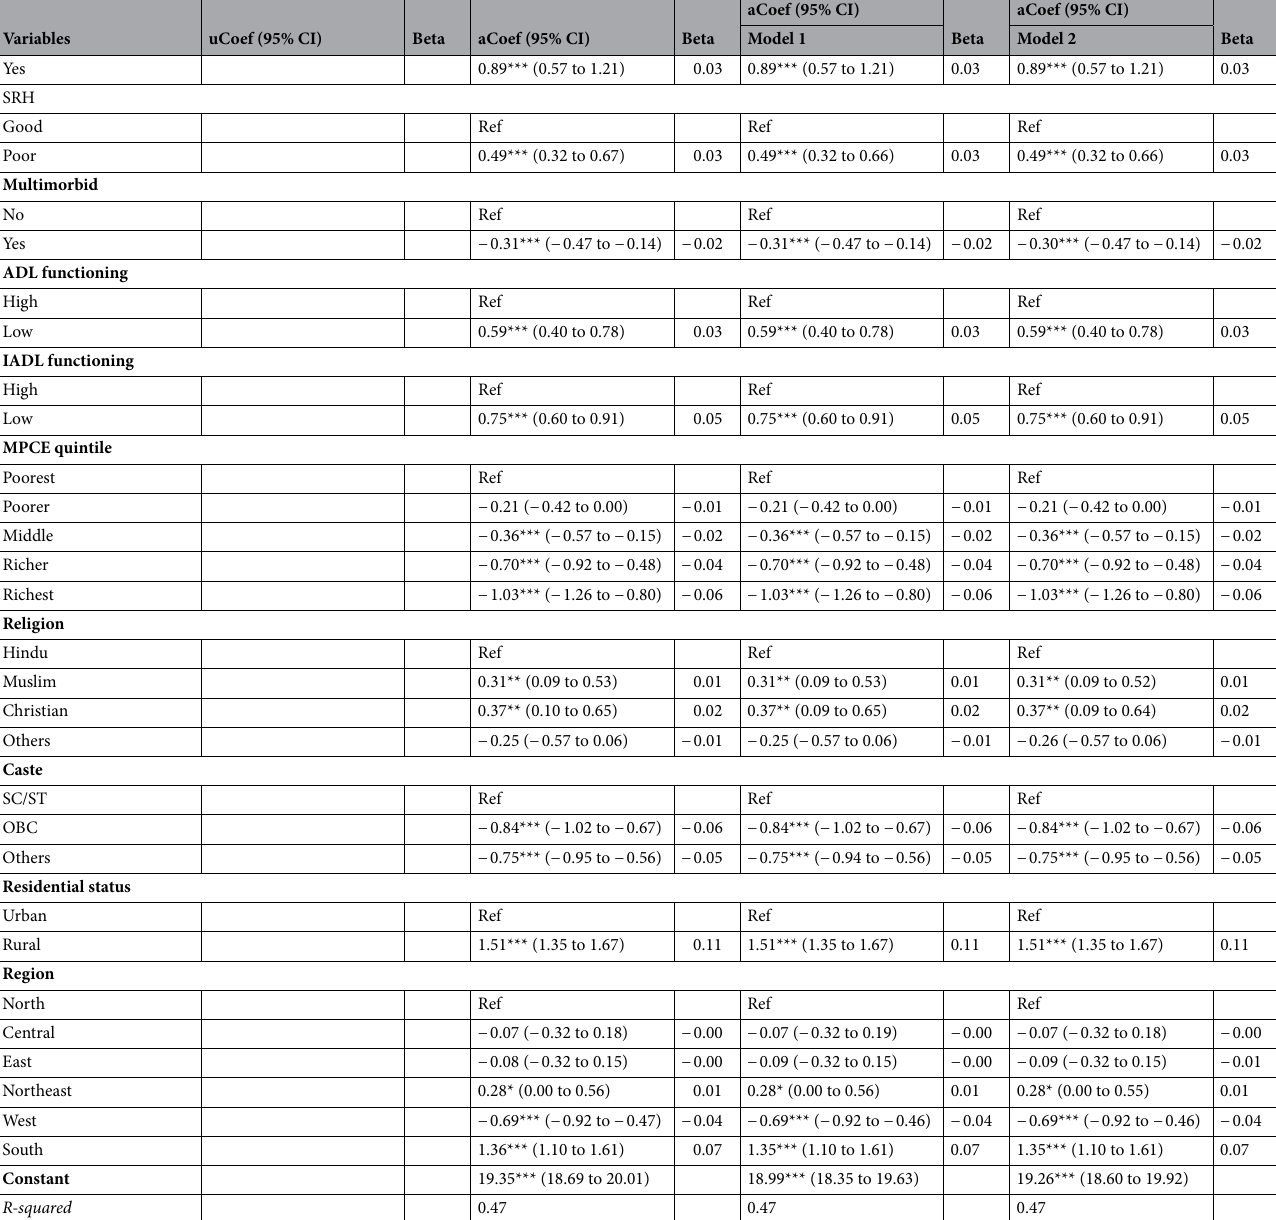
Table 3. Moderated multivariable linear regression estimates of cognitive impairment with individual, health and household characteristics among older adults. *if p < 0.05, **if p < 0.01, ***if p < 0.001; uCoef: Unadjusted regression coefficients; aCoef: Adjusted regression coefficients; Beta: Standardized beta coefficients. Model 1 and 2 are interaction models, adjusted for all the